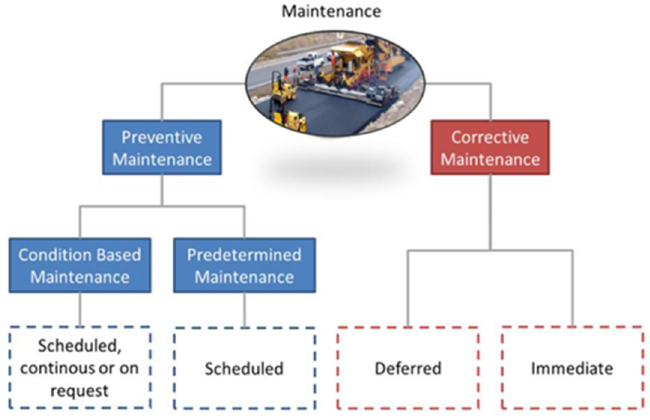
Figure 3. Maintenance strategies overview, SS-EN 13306 (2001) [47].